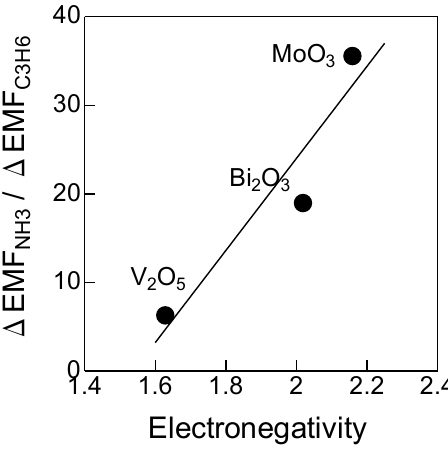
Figure 4. The relative  EMF as a function of electronegativity of added metal